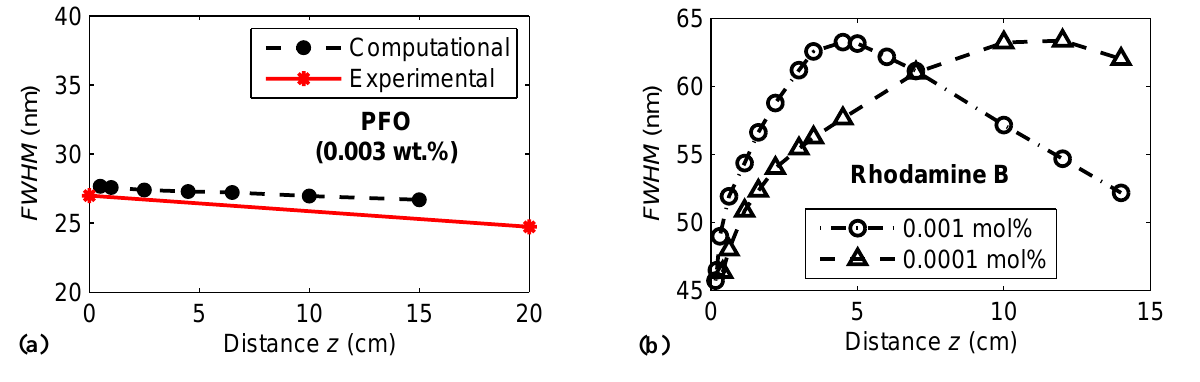
Figure 5. Full width at half maximum as a function of distance for PFO (computational and experimental) ( a ) and RB ( b ). The pump energies are well below threshold: 0.69 μ J/mm 2 for PFO and 8 μ J/mm 2 for RB. Dye concentrations are